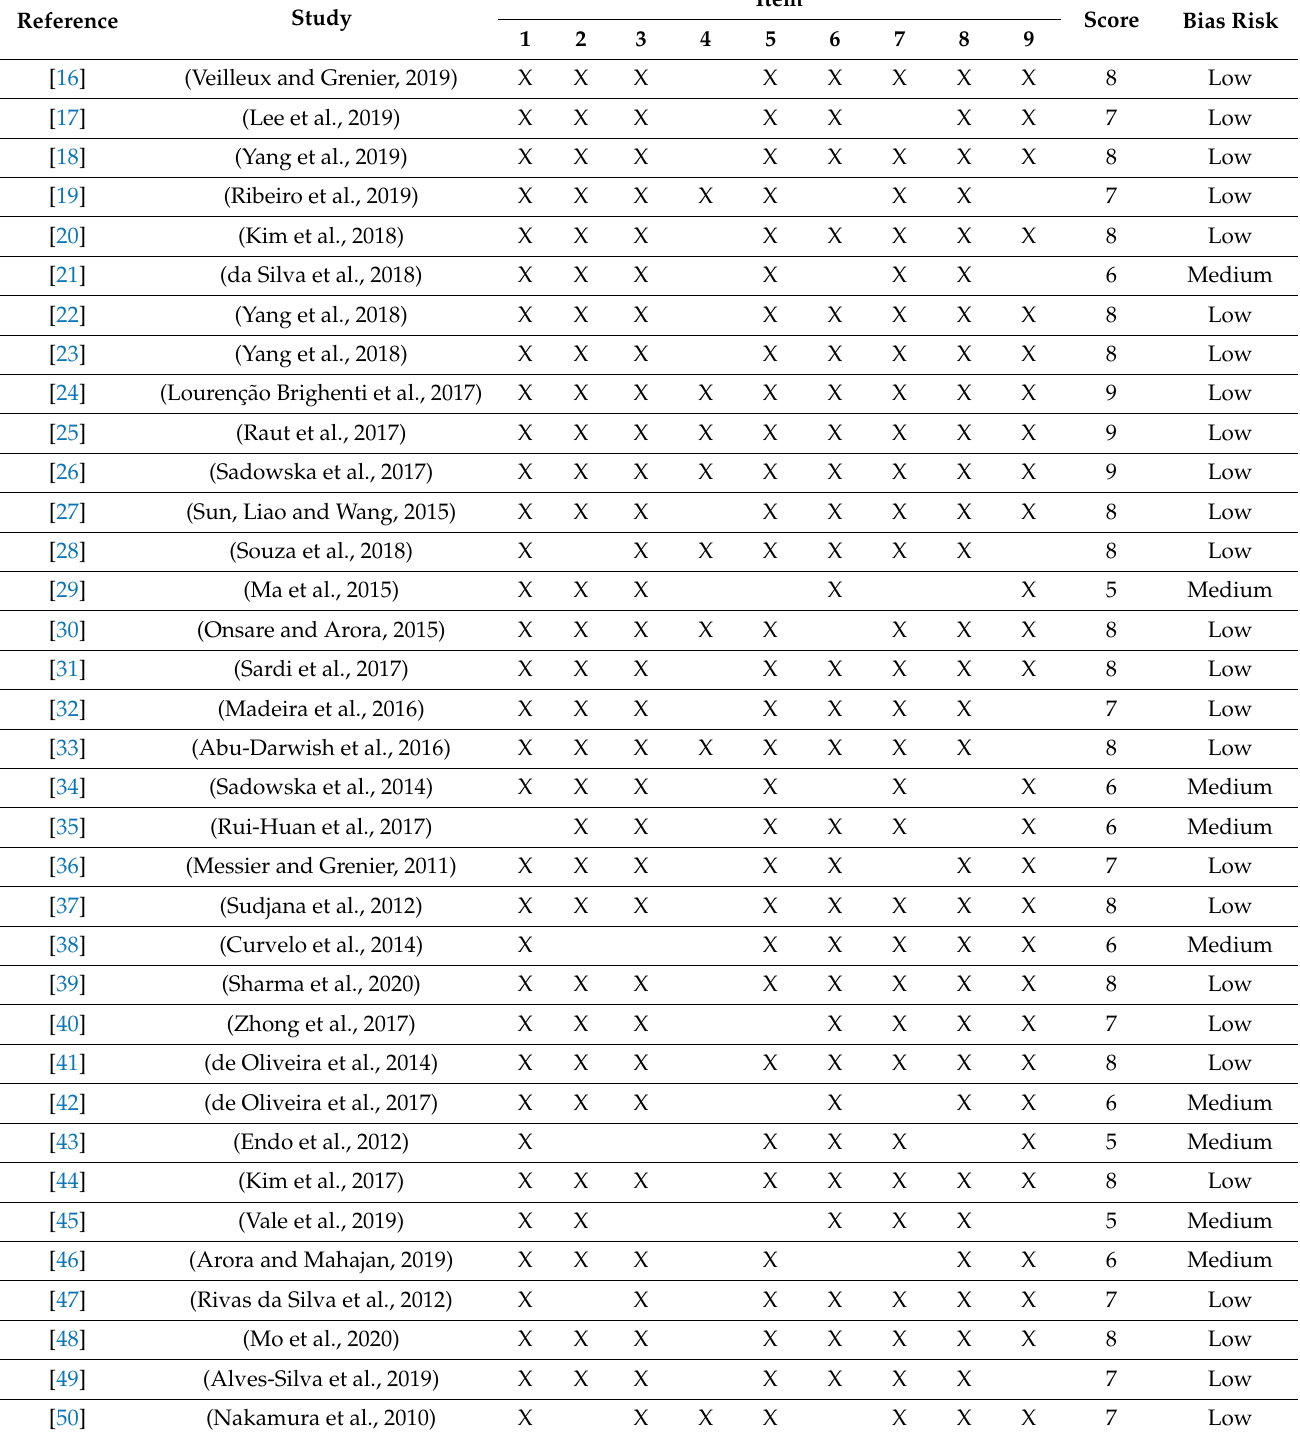
Table 2. Risk of bias